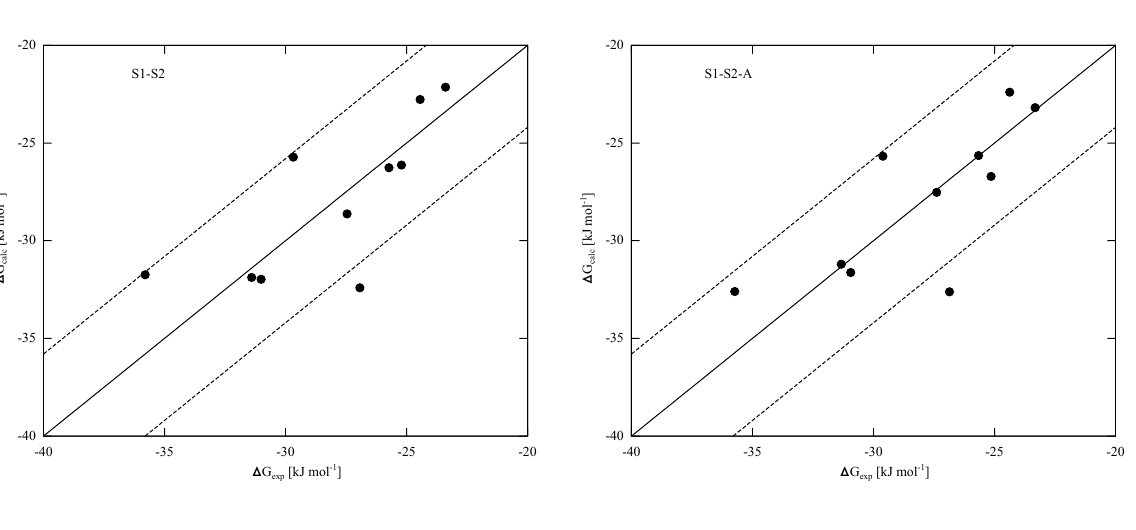
Figure 2. Correlation between calculated ( ∆ G energies obtained for LIE models S1–S2 ( a ) and S1-S2-A ( b ), which combine results from all MD simulations. The solid line indicates ideal correlation between ∆ G and thin dashed lines represent errors of